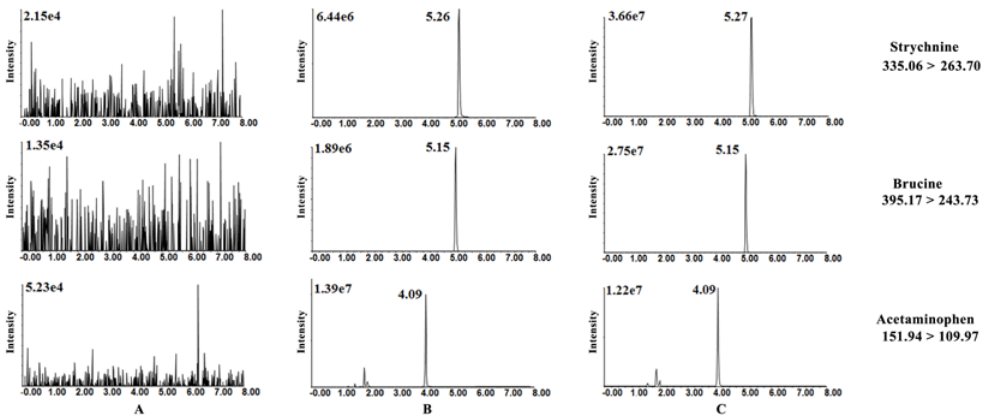
Figure 7. Typical multiple reaction monitoring chromatograms of each analyte and IS. ( A ) Blank brain homogenate, ( B ) spiked brain homogenate with analytes and IS (QC1), and ( C ) the brain homogenate obtained 0.5 h after oral administration.